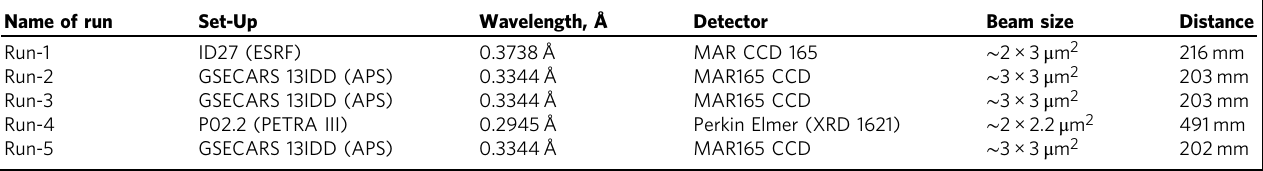
Table 2 The details of experimental set-ups and other technical aspects of XRD experiments with NiO at high-pressures. Name of